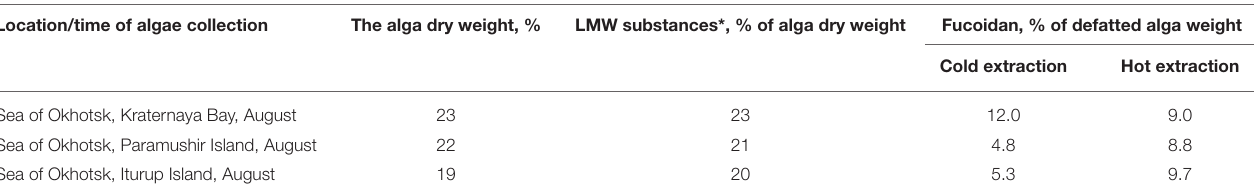
Cold extraction Hot extraction